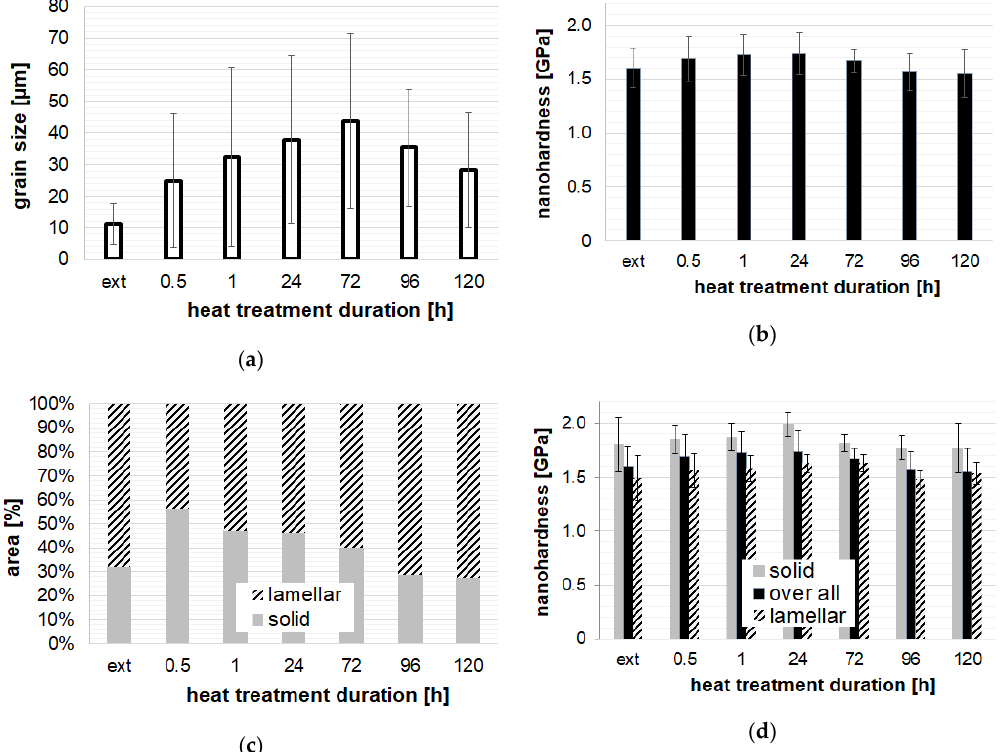
Figure 4. Microstructure depending on ( a ) grain size, ( b ) overall nanohardness, ( c ) area fraction of Mg matrix grains without LPSO lamellae (solid) and with LPSO lamellae, and ( d ) nanohardness of individual grains compared to overall hardness: Mg matrix grains with LPSO lamellae and without obvious LPSO lamellae (solid)-solution heat treatment and quenched in 55 ◦ C water (numbers stand for heat treatment